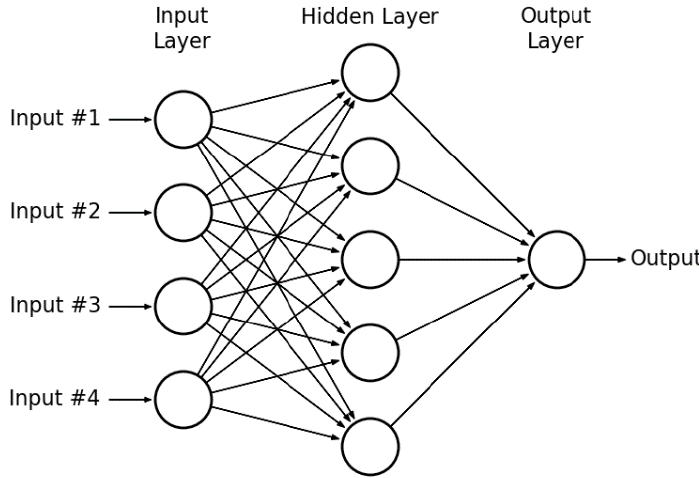
Figure 3. Schematic description of a three-layer ANN and of the elements of its (mathematical)